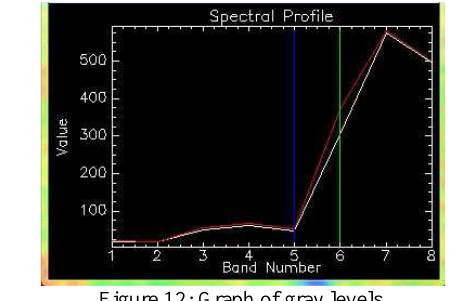
Figure 12: Graph of gray levels.